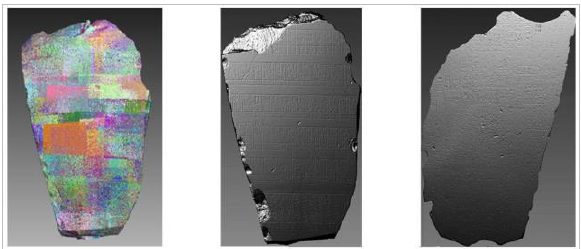
Figure 3: 3D scanning and data registration processing steps: frames alignment.